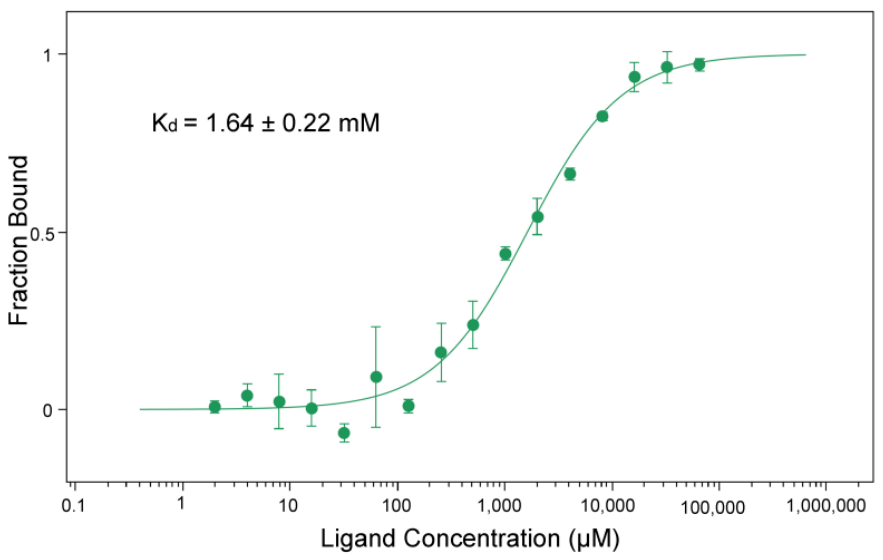
Figure 5. Binding affinity of AMP-PNP for BceF kinase domain. The binding of AMP-PNP to BceF kinase domain was quantified using microscale thermophoresis. The protein-bound fraction is plotted against AMP-PNP concentration. Error bars correspond to the standard deviation for three replicates. The standard error of the regression was